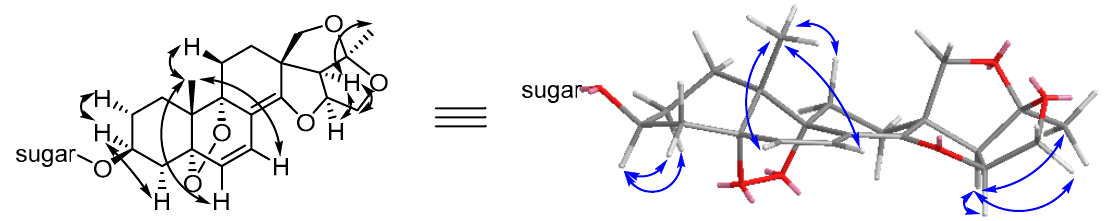
Figure 3. Key NOE correlations (H ↔ H) in the aglycone moiety of 1 .